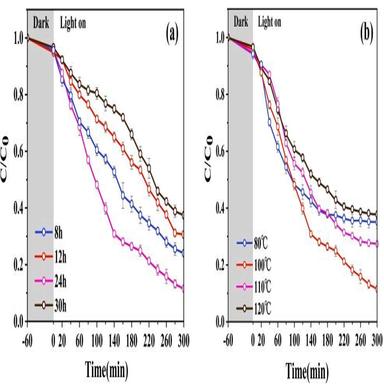
Effects of Fe-UiO-66 preparation conditions on the degradation of sulfameter: (a) synthesis time and (b) preparation temperature.